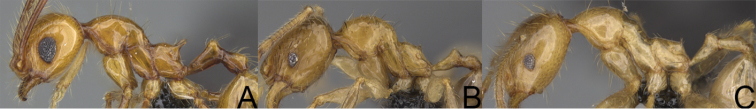

Minor worker, profile. Pheidole
oculata Forel (A), Pheidole
lutea sp. nov. (B), Pheidole
madecassa (C).